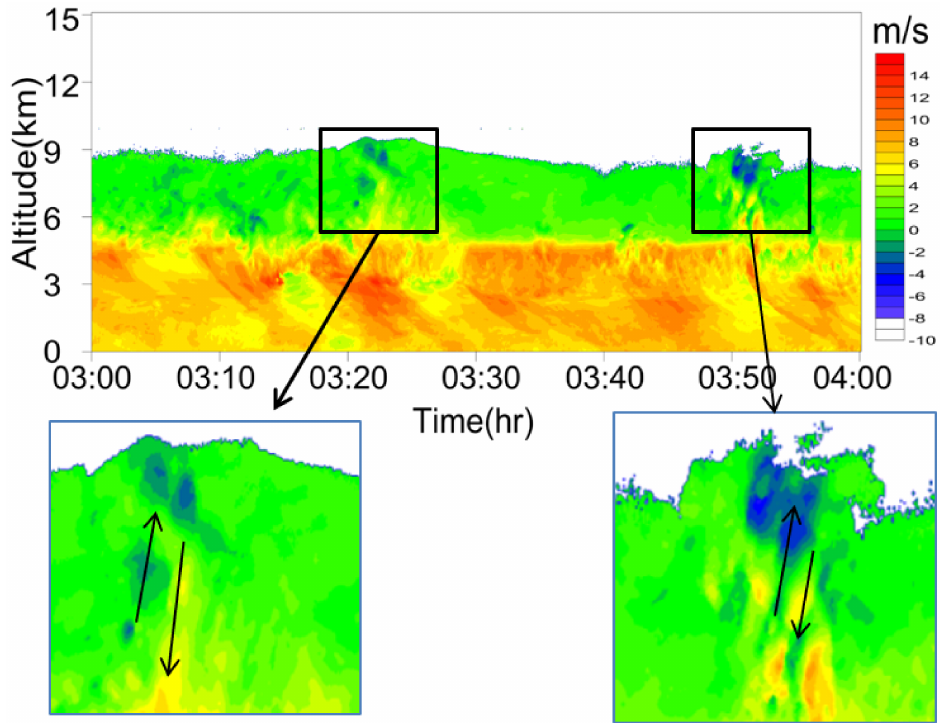
Figure 7. The vertical velocity of particles detected by the C-FMCW radar on 28 June (the arrow in the enlarged picture indicates the direction of particles